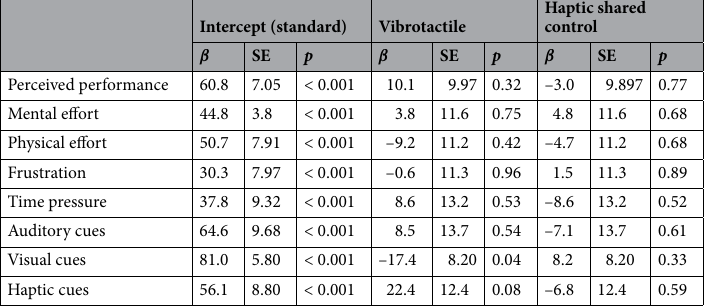
Table 2. Summary of model statistics for survey